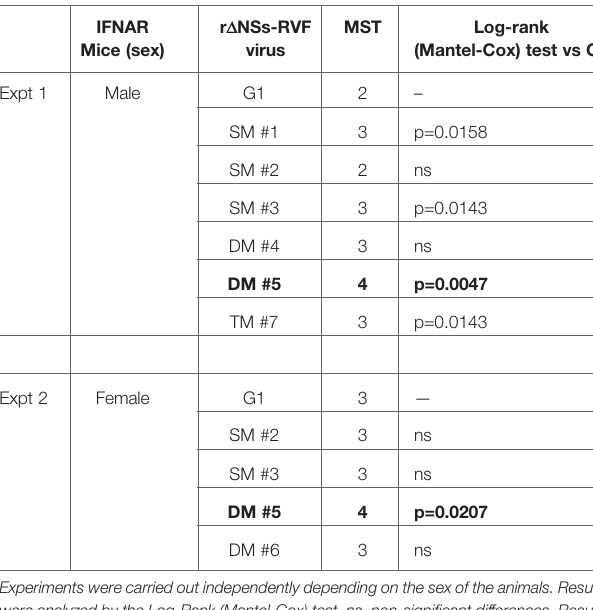
TABLE 3 | Survival, MST (median survival time, i.e., time at which fractional survival equals 50%) and statistically signi fi cance in IFNAR KO mice (n= 5) inoculated via IP with 500 pfu of the indicated viruses.